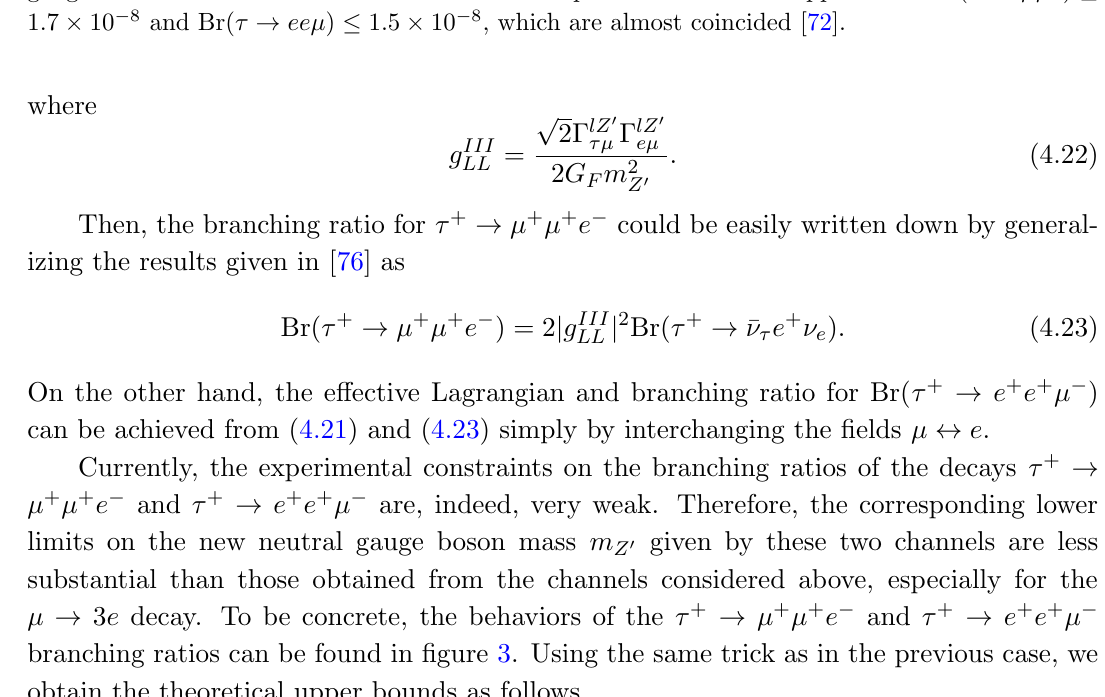
Figure 3 . Dependence of the branching ratios Br( (cid:28) ! (cid:22)(cid:22)e ) and Br( (cid:28) ! e(cid:22)(cid:22) ) on the new neutral gauge boson mass m Z 0 (cid:17) M . The blue lines correspond to the current upper limits Br( (cid:28) ! (cid:22)(cid:22)e ) (cid:20) 1 : 7 (cid:2) 10 (cid:0) 8 and Br( (cid:28) ! ee(cid:22) ) (cid:20) 1 : 5 (cid:2) 10 (cid:0) 8 , which are almost coincided